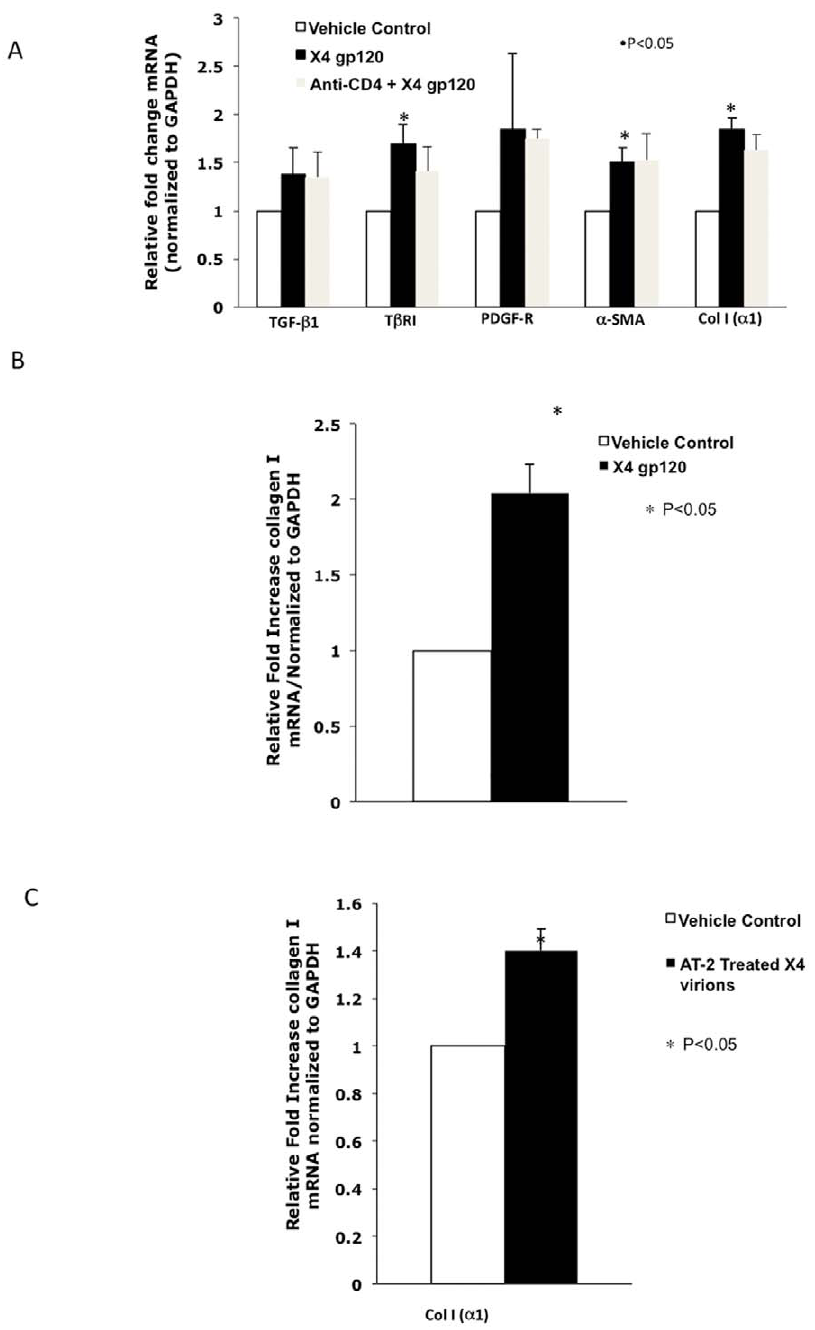
Figure 1. X4 HIV-1 gp120 induces fibrogenic gene expression in human stellate cells. (A) LX-2 cells were serum-starved for 24 hrs, treated with X4 HIV-1 gp120 at a final concentration of 500 ng/ml for 2 hours, RNA harvested, reverse transcribed, and qRT-PCR performed for TGF-ß1, type I TGF-ß receptor, a-SMA and coll I (a1) mRNA levels. To confirm X4 gp120 effects were CD4-independent, cells were pre-incubated with 25 m g/mL anti- CD4 30 minutes prior to challenge with X4 gp120. (B, C) Effect on collagen I (a1) was confirmed in primary HSCs with both X4 gp120 as well as AT-2 treated X4-tropic HIV-IIIB, which presents gp120 in its oligomeric confirmation. All data are expressed as means + / 2 standard deviation of at least three independent experiments. doi:10.1371/journal.pone.0033659.g001 endogenous ligand for CXCR4, SDF-1a, elicits pro-fibrogenic activation and collagen I expression in HSCs even in the absence effects in activated HSCs. We have also demonstrated that HIV of infection through its interactions with CXCR4. While other in vitro studies have utilized gp120 to examine effects on intrahepatic infection of HSCs is associated with increased collagen I cell populations, we show for the first time that gp120 is present in expression but in the current study we show that X4 gp120, the envelope protein of X4-tropic HIV-1, can promote HSC the livers of patients with HIV/HCV coinfection. Since the